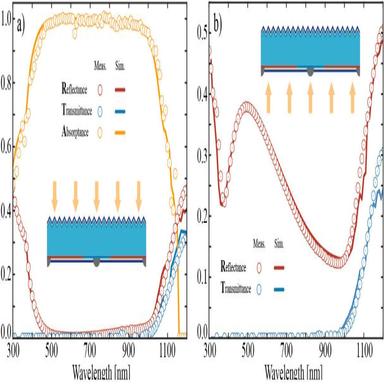
Comparison of the measured and the simulated RTA curves of the calibrated optical model of the DUT for the illumination from the a) front and from the b) back side.